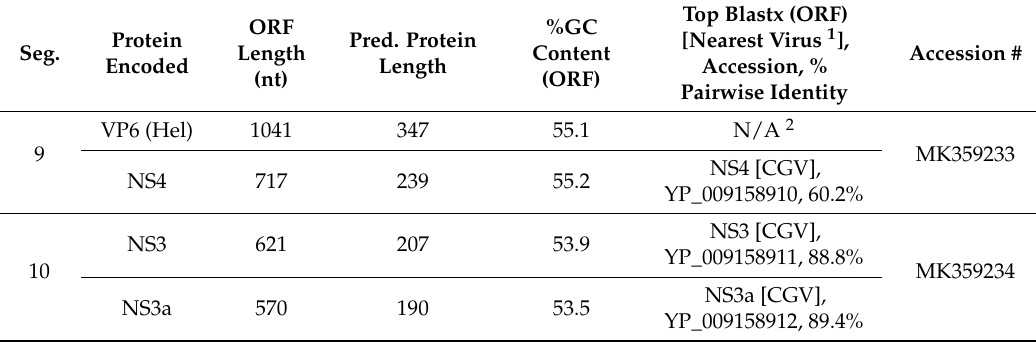
Table 4. Genetic analysis of JAPV genome segments, predicted ORFs, and predicted proteins.